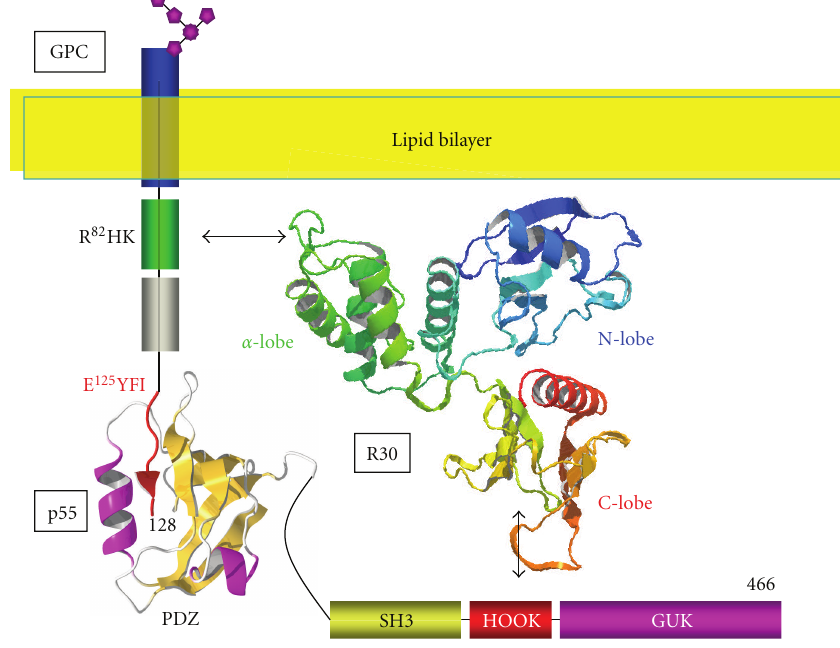
Figure 2: Organization of the R30/GPC/p55 ternary complex. The NMR structure of GPC peptide and PDZ domain complex has been previously reported [7] (PDB accession no. 2ejy). The HOOK domain is the 4.1R binding site for p55